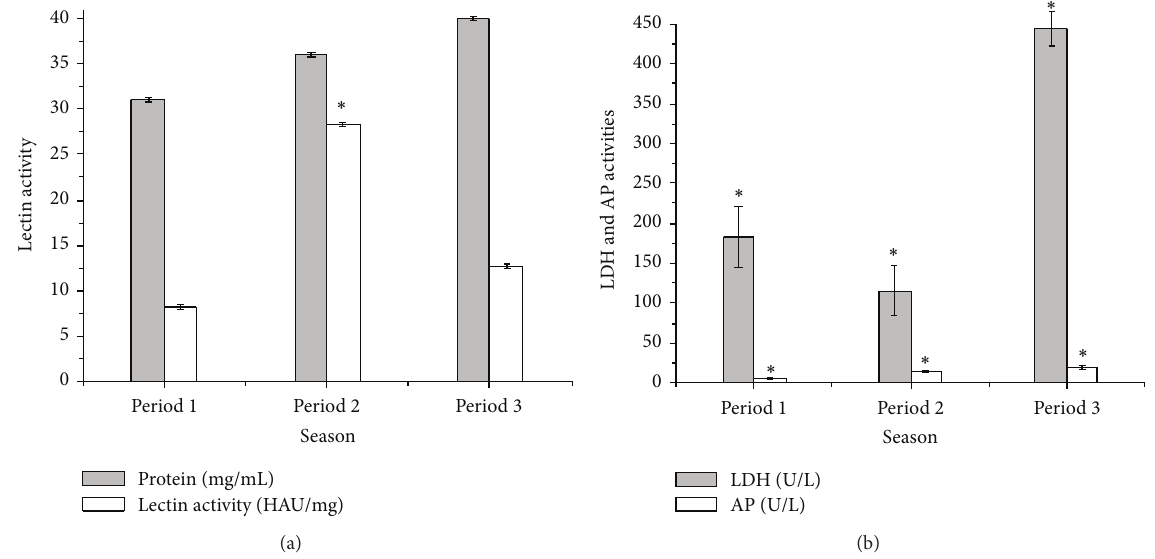
Figure 2: Variations in serum of A. gigas in Period 1 (9.99mm 3 , 26.14 ∘ C), Period 2 (2.74 mm 3 , 25.46 ∘ C), and Period 3 (5.8 mm 3 , 26.94 ∘ C) to lectin activity (specific hemagglutinating activity) and serum protein concentration (a); LDH: lactate dehydrogenase activity and AP: alkaline phosphatase activity (b). ( ∗ ) Significant ( 𝑃 < 0.05